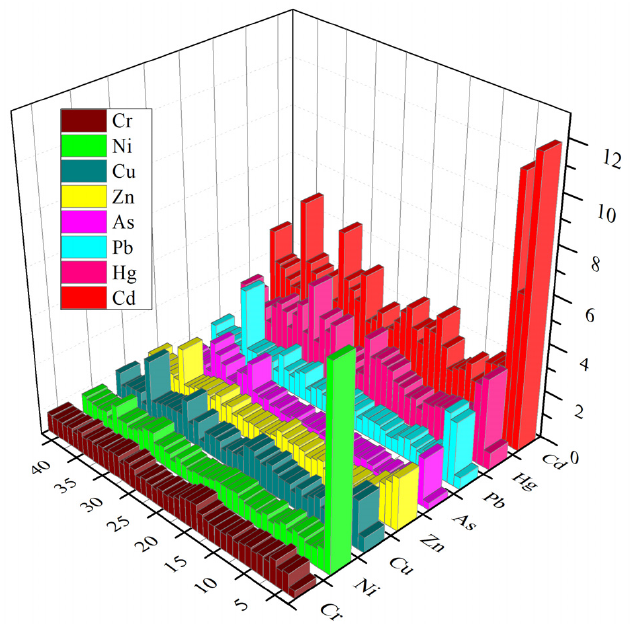
Figure 5. Three-dimensional plots of enrichment factor (EF).